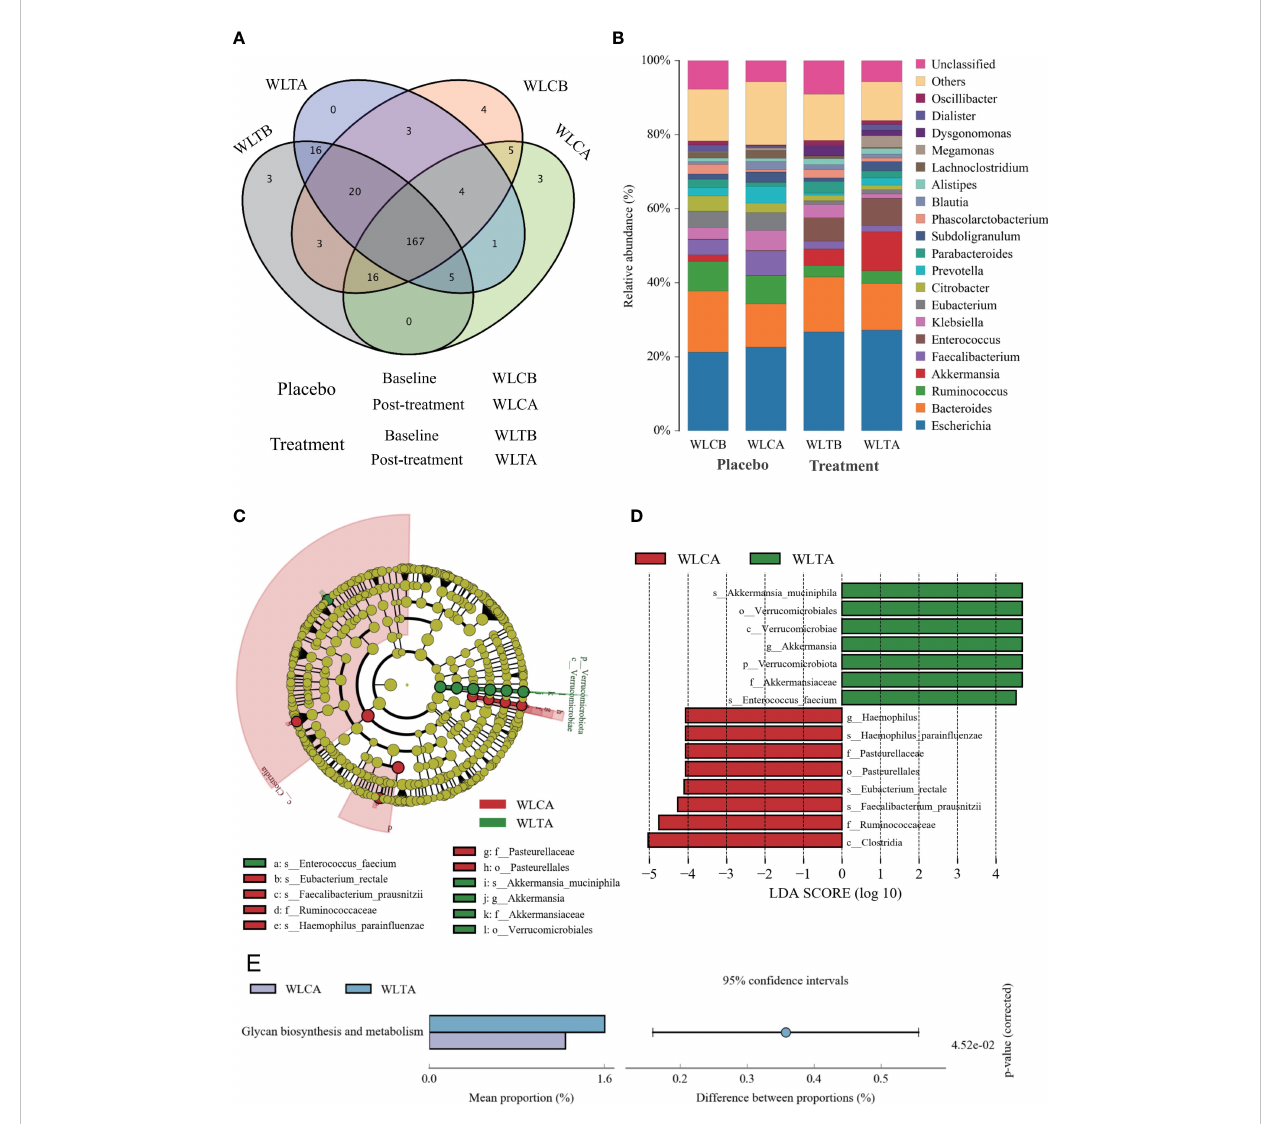
FIGURE 7 The structures and compositions of the gut microbiota before and after treatment in the two groups. (A) The Venn diagram of OTUs (species). (B) The composition of relative abundance on genus. (C) Phylogenetic cladogram of microbial lineage in fecal samples of treatment group and placebo group, with colors representing the most abundant differences in composition. (D) Key phylotypes of the gut microbiota responding to W- LHIT treatment. The histogram shows the lineage with LDA value of 4 or higher determined by LEFSe. (E) Key KEGG metabolic pathway responding to W-LHIT